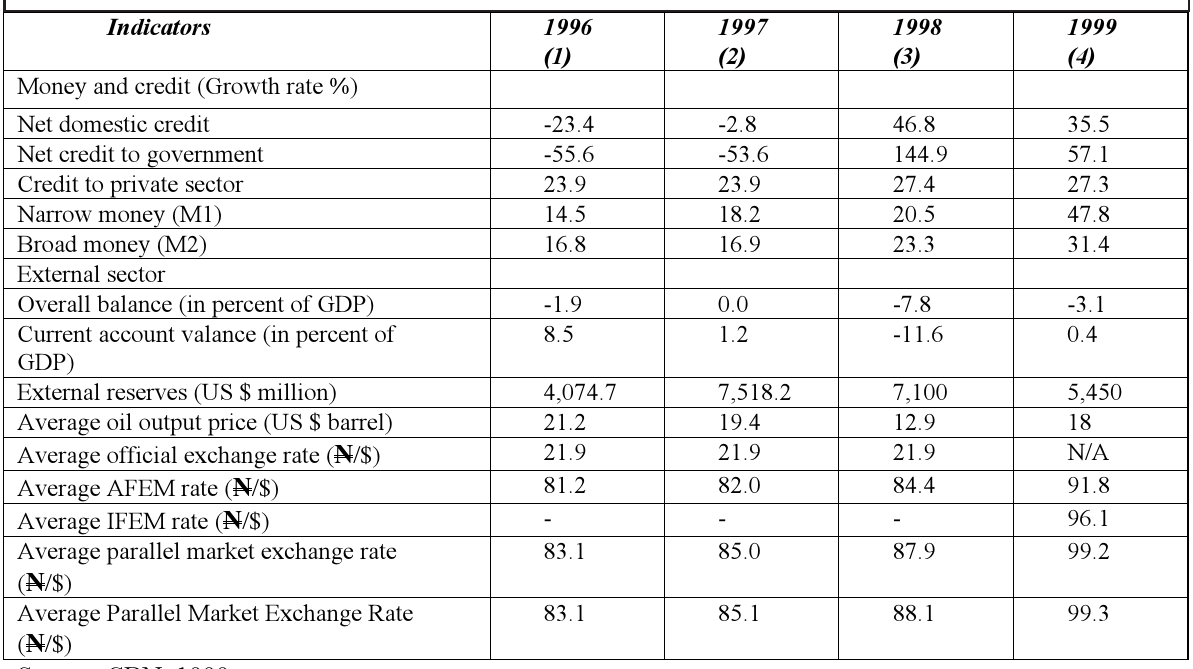
Table 12. Selected Marcroeconomic